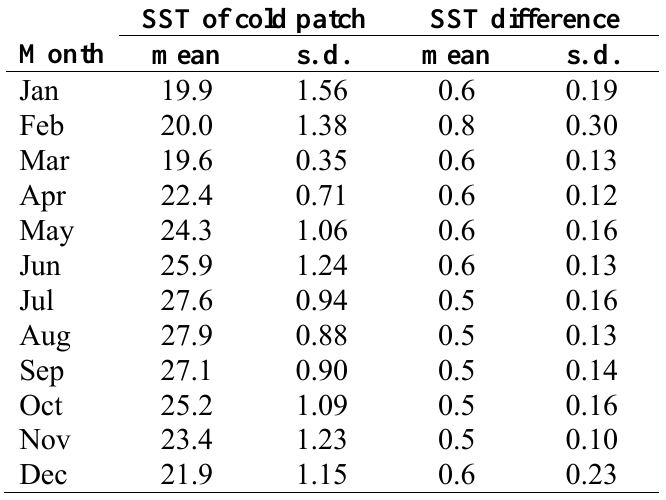
Table 2. Mean and standard deviation (s.d.) of monthly SST of the cold patch and its difference to the surrounding waters (unit: °